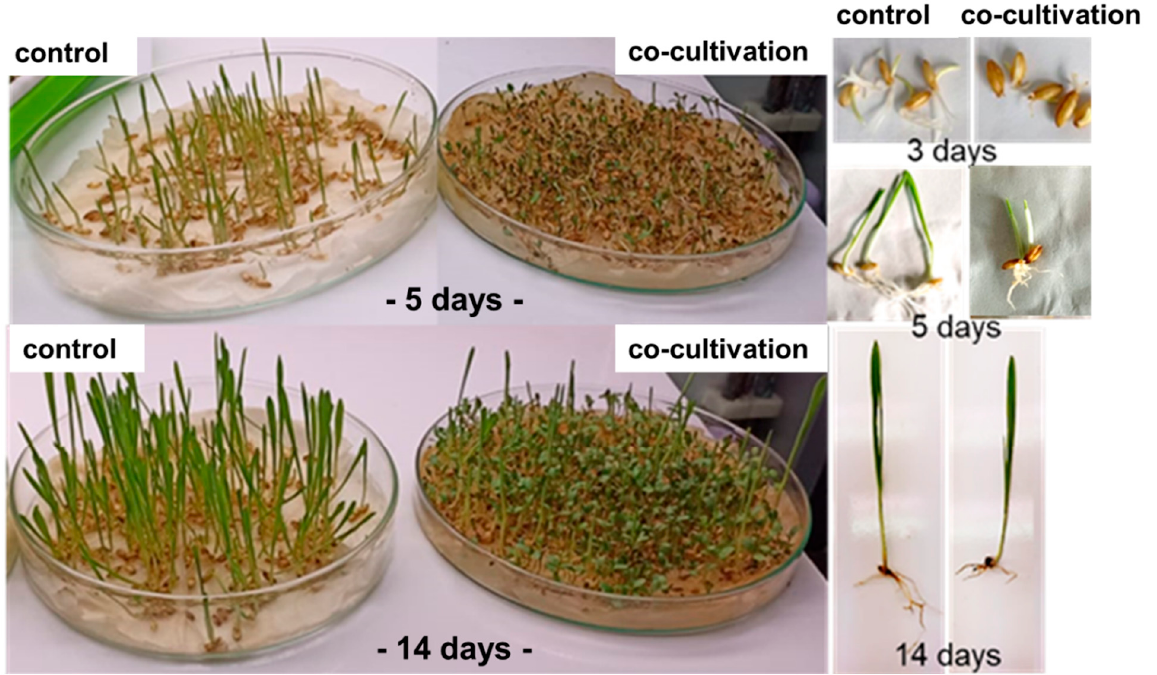
Figure 1. Co-cultivation of alfalfa seed with barley for two weeks. The germination of barley was massively retarded. The delay accounts for about three days in comparison to the controls. In addition, the root and shoot development was significantly reduced in comparison to the controls after 14 days. The experiment was repeated three times.